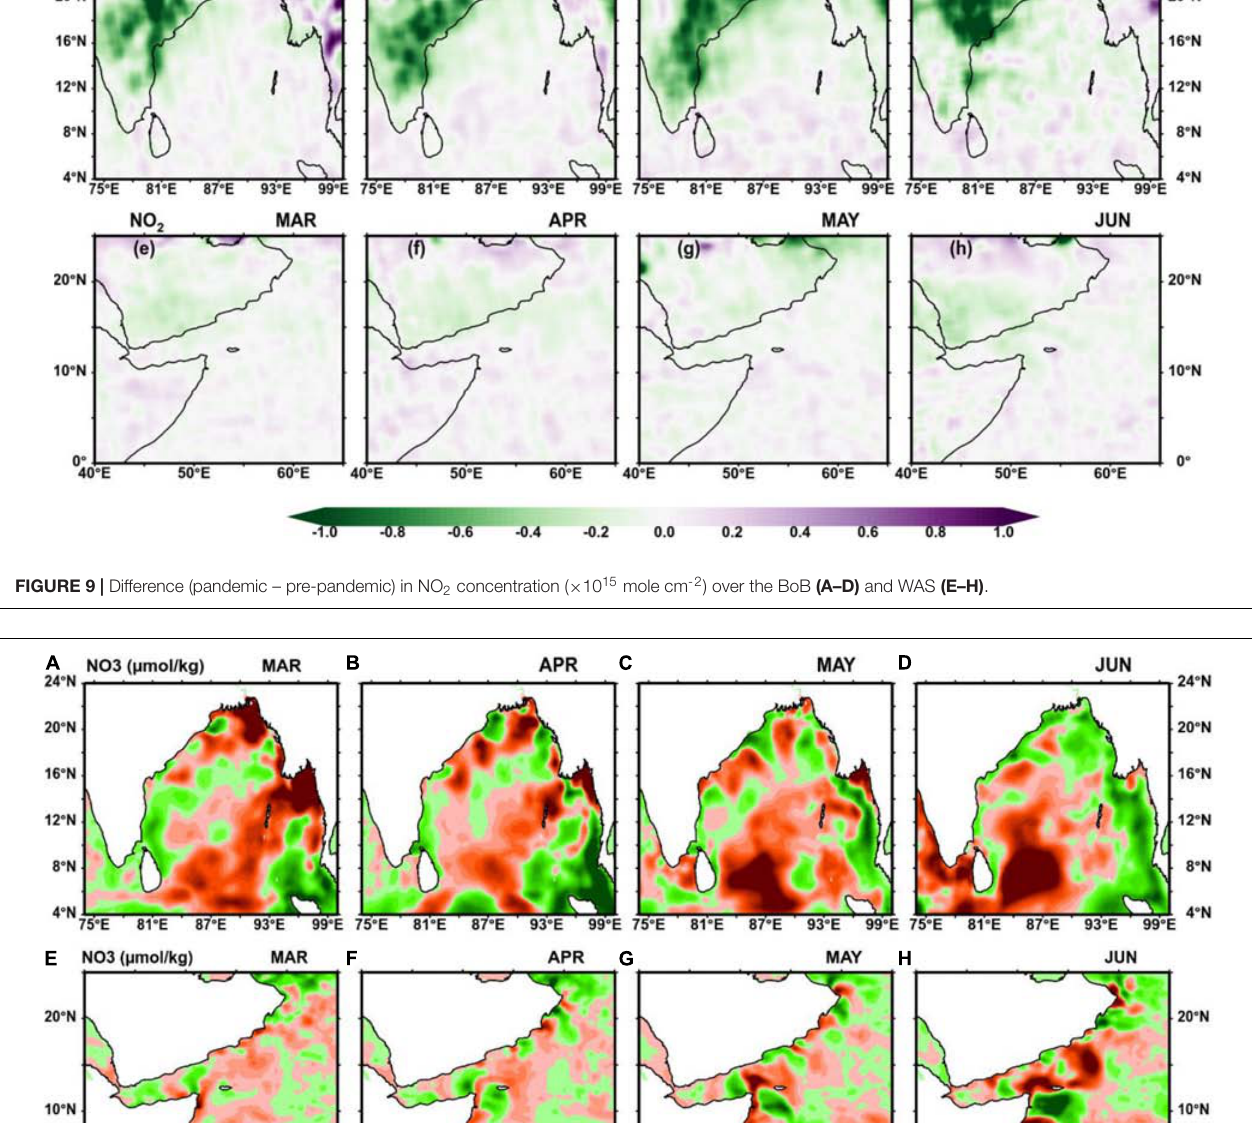
AOD at 550 nm are used. Nitrogen dioxide (NO 2 ) data are obtained from the ozone monitoring instrument (OMI) within tropospheric column of 30% cloud screened level 3 product (OMNO2d.v003) with 0.25 ◦ × 0.25 ◦